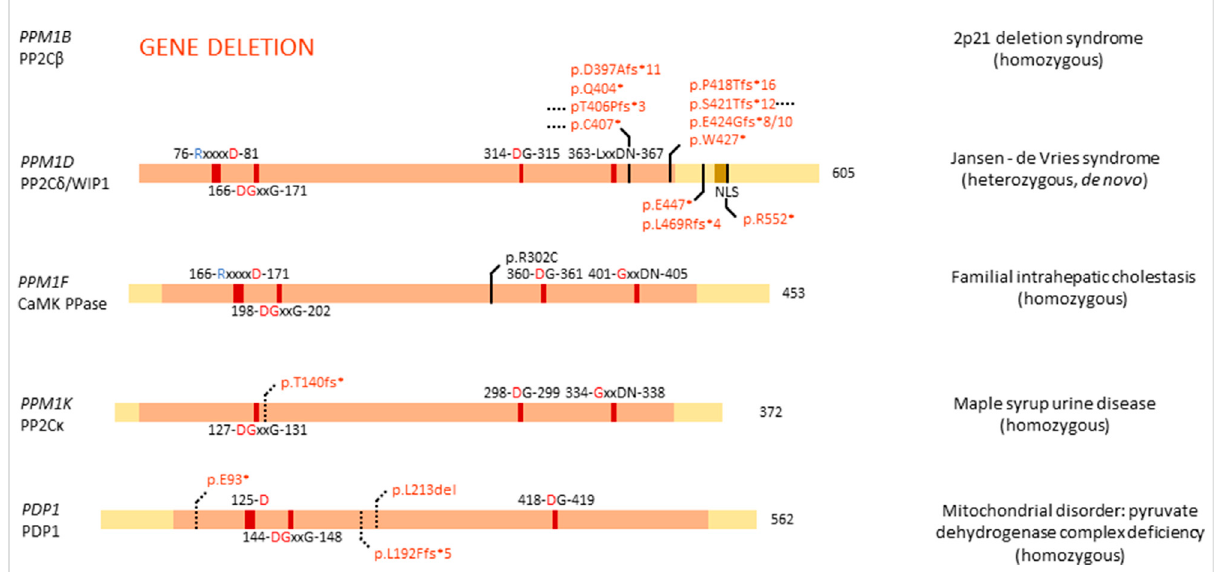
FIGURE 5 Overviewofcongenital disease-causing variantsinPPMSer/Thrphosphatases.VariantsinthePPMphosphatases aredisplayed,withconserved aminoacidsanddomainsindicated.NLS,nuclearlocalisationsignal.Redaminoacidsdenotemetalbinding,bluedenotephosphatebinding.Variants inreddenotealleged orproven loss-of-functionmutants,variantsinblack:pathogenic mechanismunknown.Dotted linesnearvariantsdenotethat functional or molecular data have been